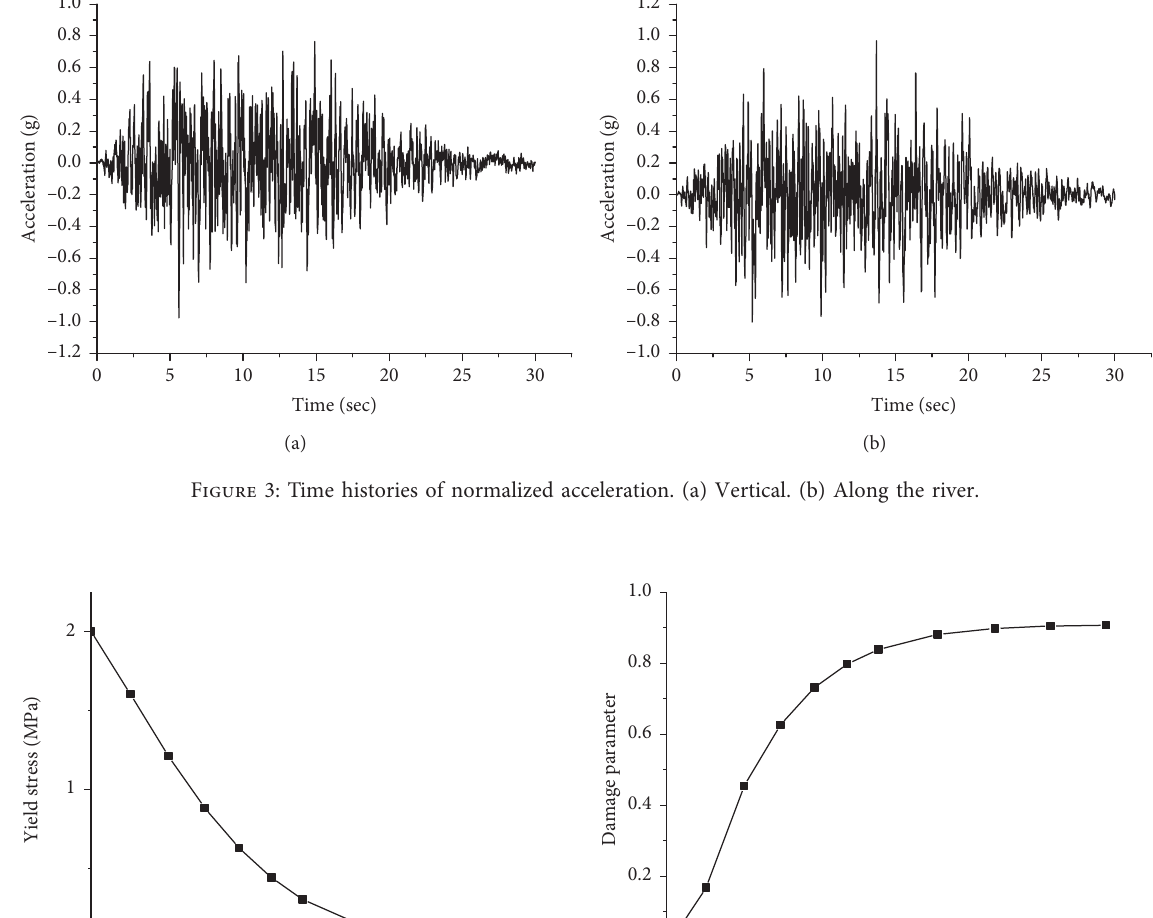
25 concrete. (a) Tension stiffening. (b) Tension damage. 90